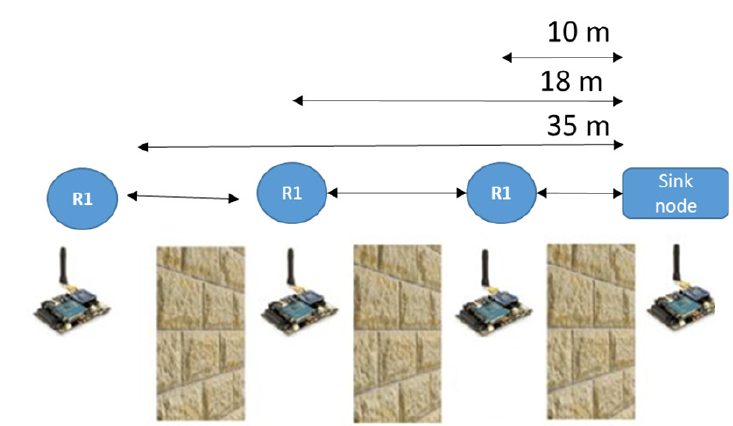
Figure 17. Wireless sensor nodes spread over non-line of sight with wall blocked obstacles at the German Jordanian University